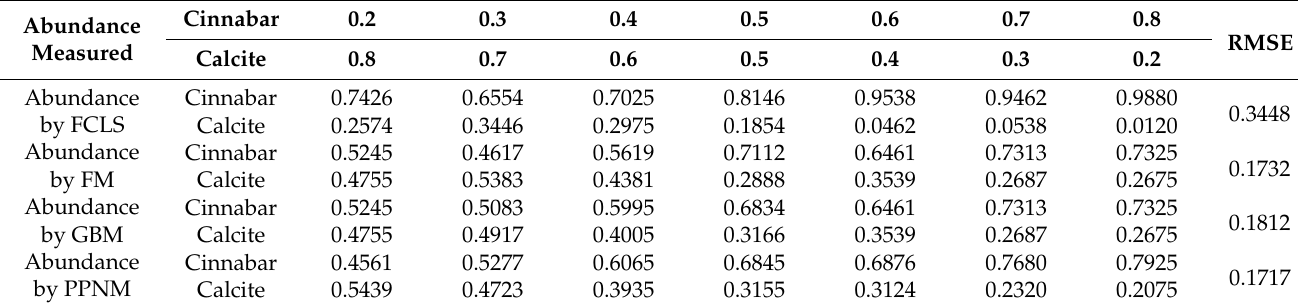
Table 6. Abundance estimated by different approaches for mixed pigment samples of cinnabar and calcite.